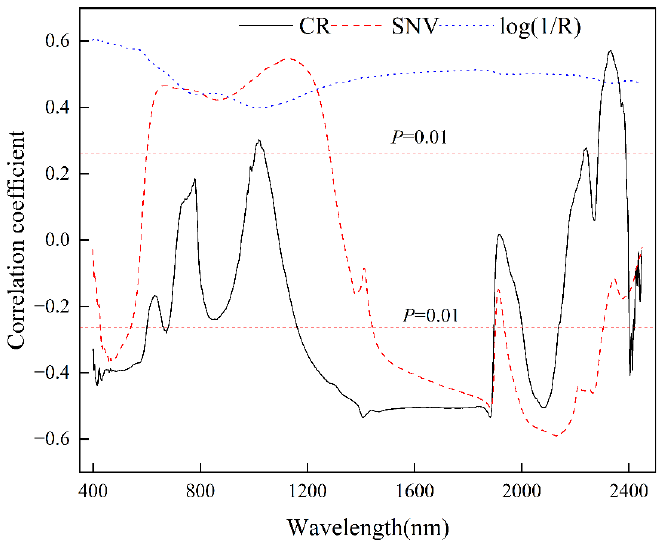
Figure 6. Correlation coefficient between spectra and iron oxide content. Table 2. The number of wavelengths passing the significance test ( p < 0.01) and the maximum cor- relation coefficient for different spectra.